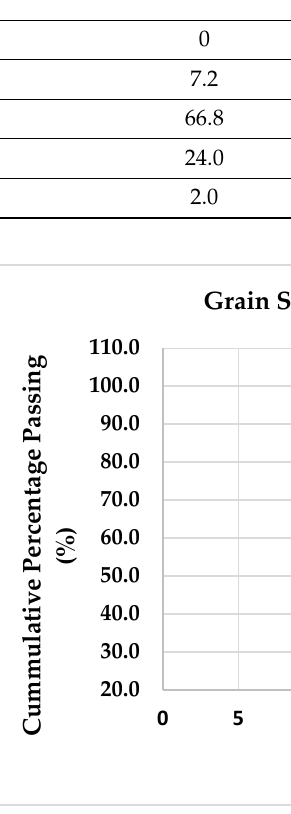
Figure 1. Grain size distribution of coarse aggregates.